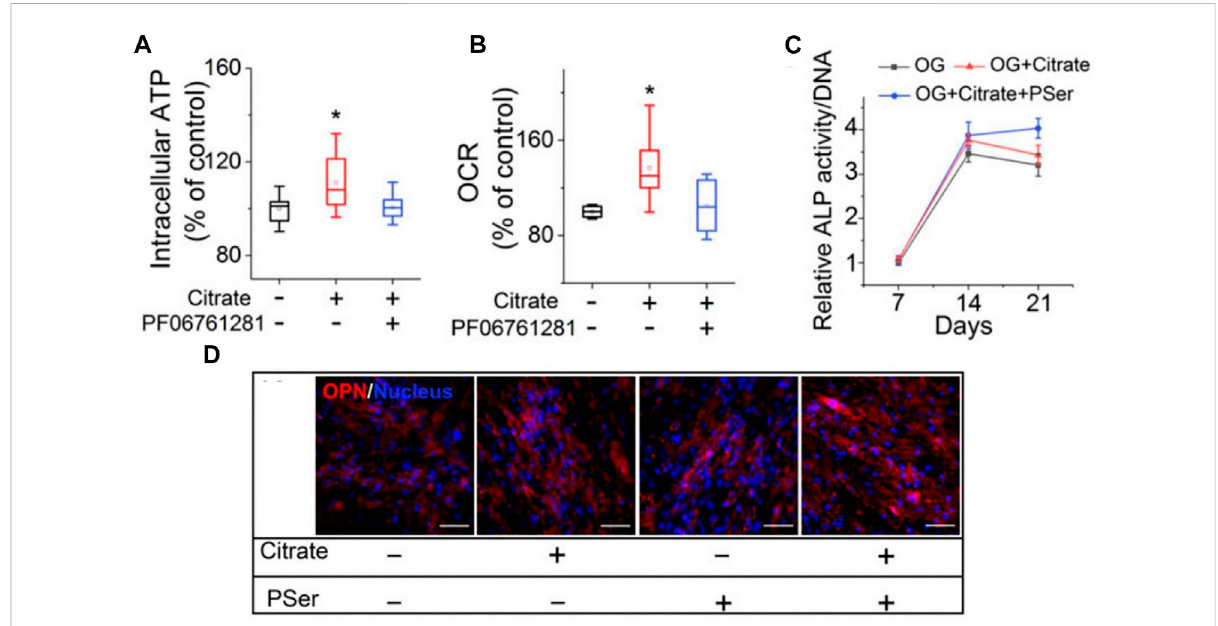
FIGURE 9 Citrate promotes osteogenesis by regulating metabolism. (A) Intracellular ATP assay. (B) OCR study. (C) ALP production of differentiated hMSCs after7,14and21 daysofdifferentiationinOGmediumsupplementedwithcitrateorcitrateandPSer. n =4biologicalreplicatespergroup;alldataare presented as mean ± SD; * p < 0.05. (D) Immuno fl uorescence staining of OPN (red) with DAPI nuclear counterstain (blue) expression after 21 days of differentiation in OG medium supplemented with citrate, PSer, or both. Plus (+) and minus ( − ) signs indicate the presence and absence, respectively, of citrate and other speci fi c chemicals in GM/OG medium. (Huard et al., 2015; Ma et al., 2018)(Reprinted with